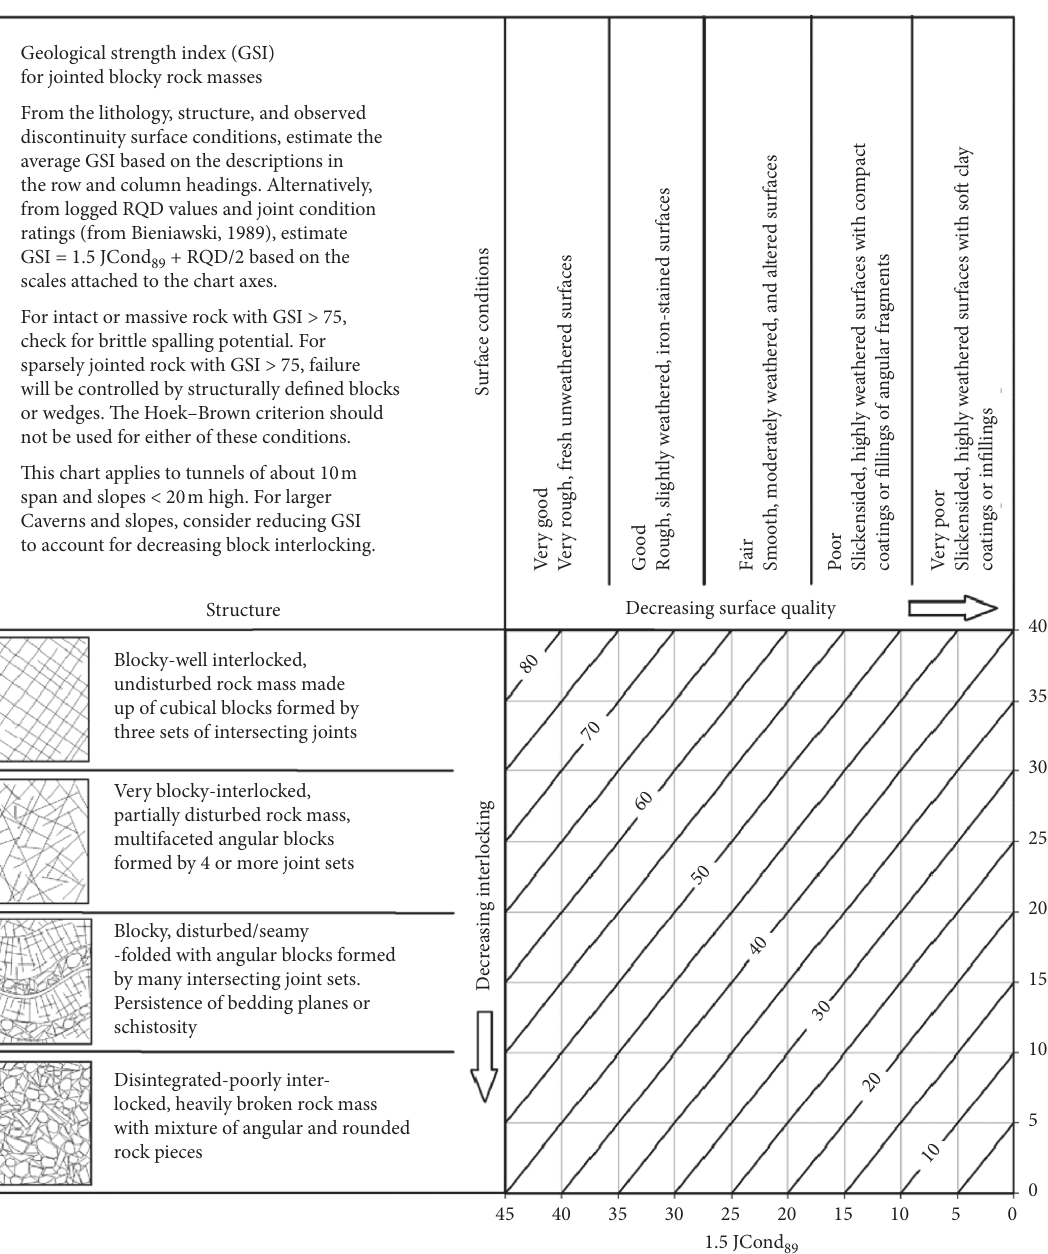
89 and scale B by RQD/2